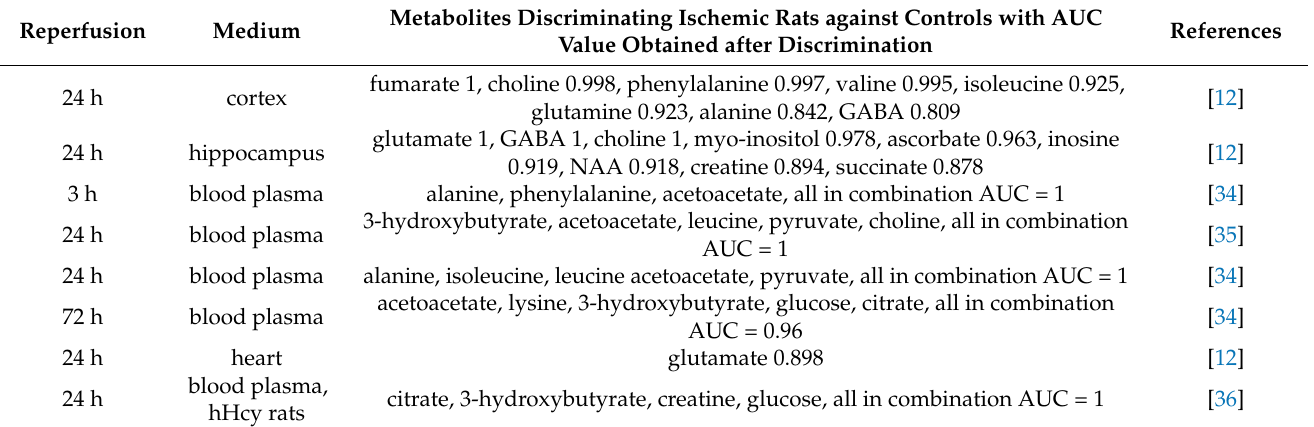
Table 2. Discrimination analysis towards biomarkers in the 4VO animal model of cerebral ischemia in rats, metabolite levels evaluated by 1 H NMR